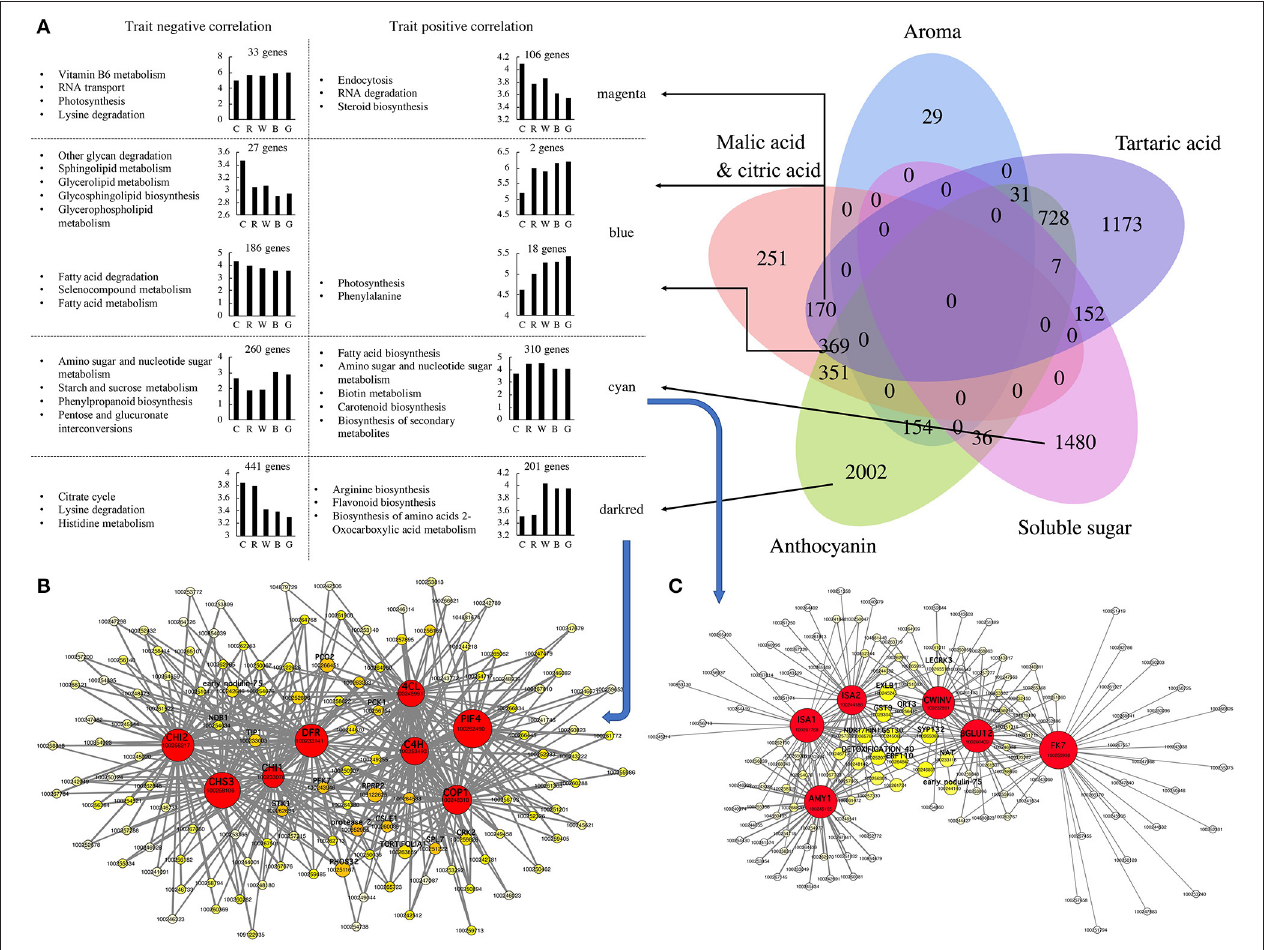
FIGURE 4 | Based on WGCNA (weighted gene co-expression network analysis) to screen anthocyanins, soluble sugars, organic acids and aroma synthesis and metabolism hub genes. (A) Construct a Venn diagram based on hub genes screened by anthocyanins, soluble sugar, tartaric acid, aroma, and malic acid and citric acid. Perform KEGG enrichment analysis based on the hub genes in different blocks of Venn diagram, count the number of hub genes that are positively and negatively correlated with the target trait, and draw a histogram of different correlations. Cytoscape representation of co-expressed genes in modules “darkred (B) and “cyan” (C) . Hub genes are in circle. Each node represents a gene, the color of the circle indicates its connectivity, the size of the node represents the number of connected genes. C: control (no light treatment), B: blue light treatment, R: red light treatment, W: white light treatment, G: green light treatment.